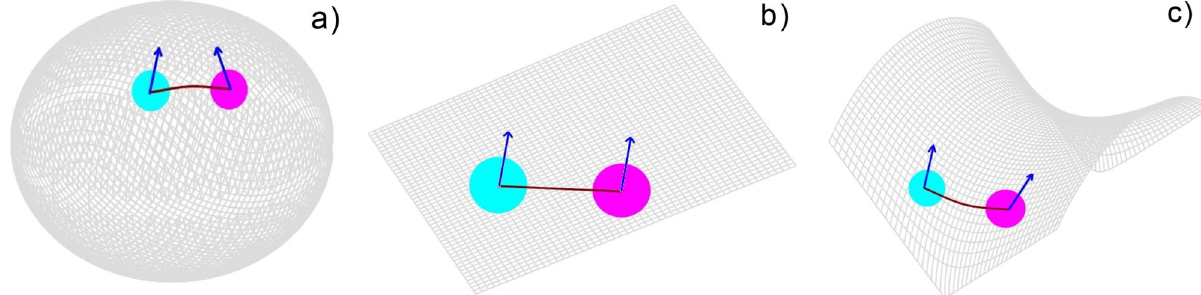
Figure 1. Manifolds with constant Ricci curvatures; ( a ) positive, ( b ) zero and ( c )